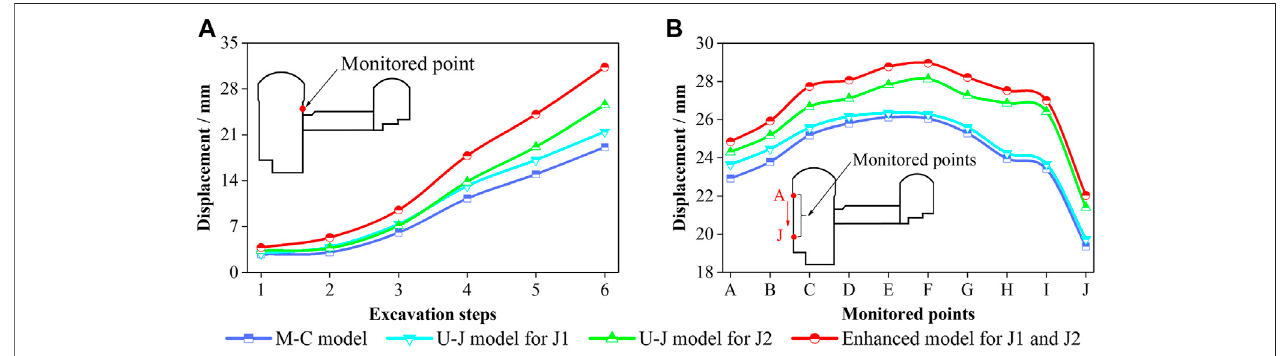
FIGURE 12 | Total displacement of (A) the monitored point as the excavation proceeds and (B) the monitored points upon completion of the excavation.